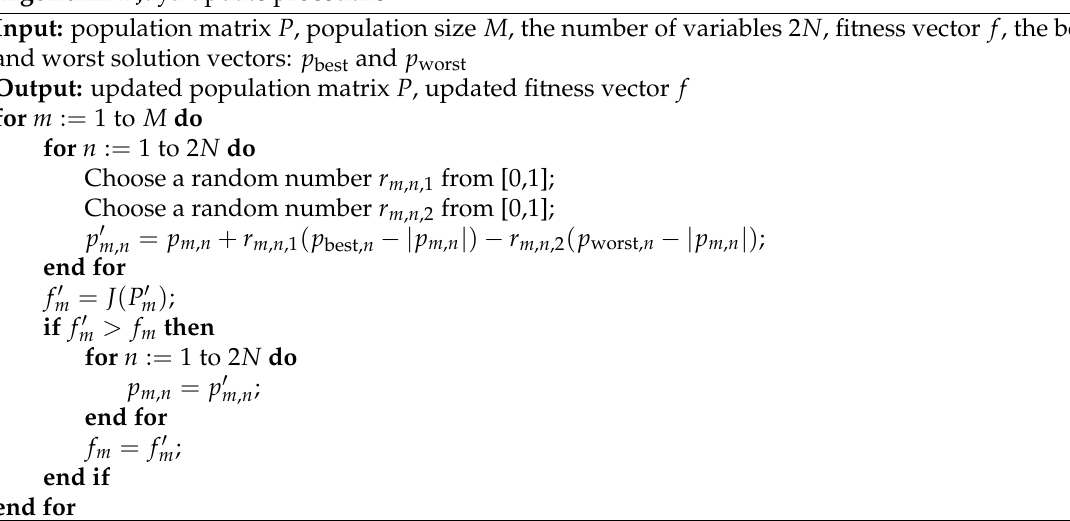
Algorithm 1 Jaya update